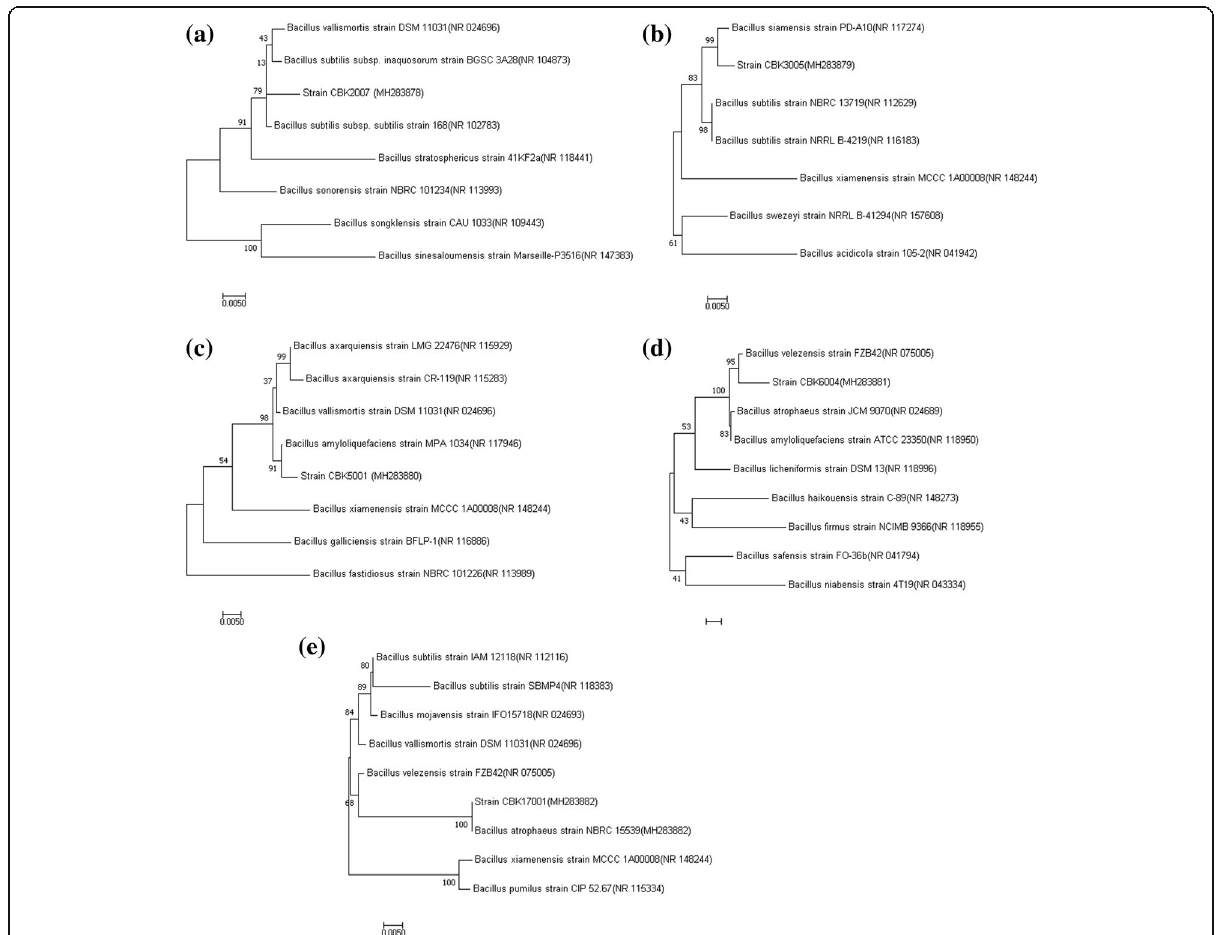
Fig. 2 a – e Phylogenetic tree of CBK2007, CBK3005, CBK5001, CBK6004, and CBK17001 respectively as constructed using MEGA 6 software by the